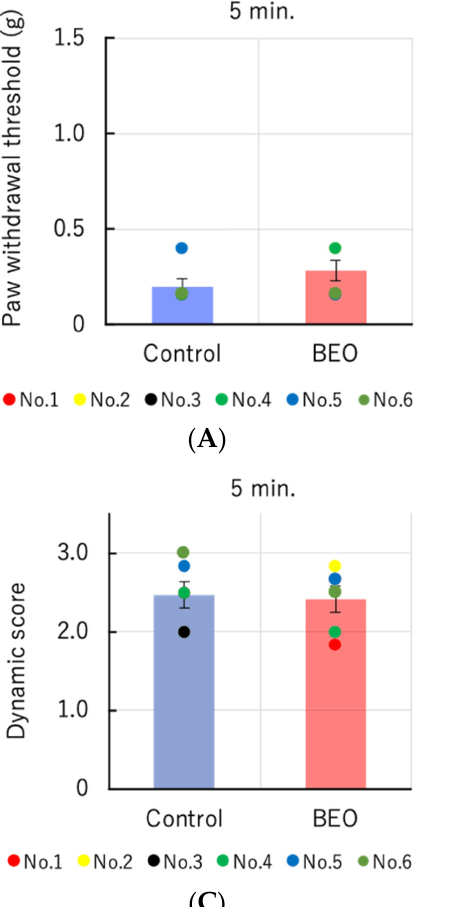
Figure 4. Effect of transdermal administration of a single therapeutic dose of NanoBEO on static ( A , B ) and dynamic ( C , D ) mechanical allodynia induced by partial sciatic nerve ligation (PSNL). NanoBEO reduces significantly static and dynamic mechanical allodynia occurring 30 min after the beginning of the test. Empty cream, used as a control, does not prove efficacy on both types of allo- dynia. The data presented are expressed as mean ±S.E.M. ( n = 6). The value of * p < 0.05 is considered statistically significant.